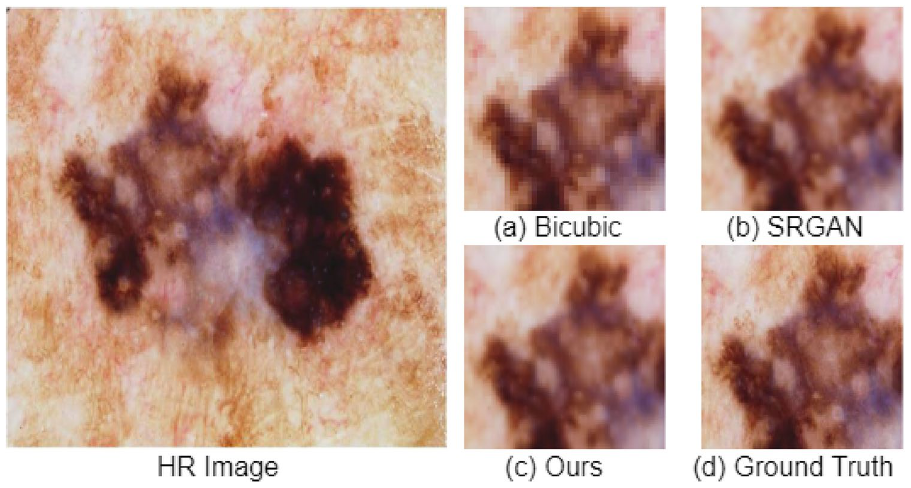
Figure 10. Small region results on image from ISIC skin cancer dataset. The sub-region for ( a ) Bicubic interpolation. ( b ) SRGAN 31 . ( c ) Proposed architecture. ( d ) Ground truth HR image.